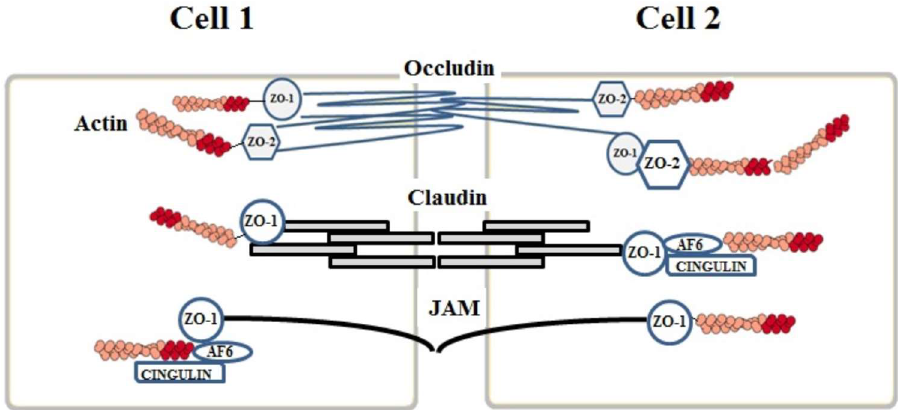
Figure 1. Molecular organization of the endothelial junctional complex in the blood-brain barrier